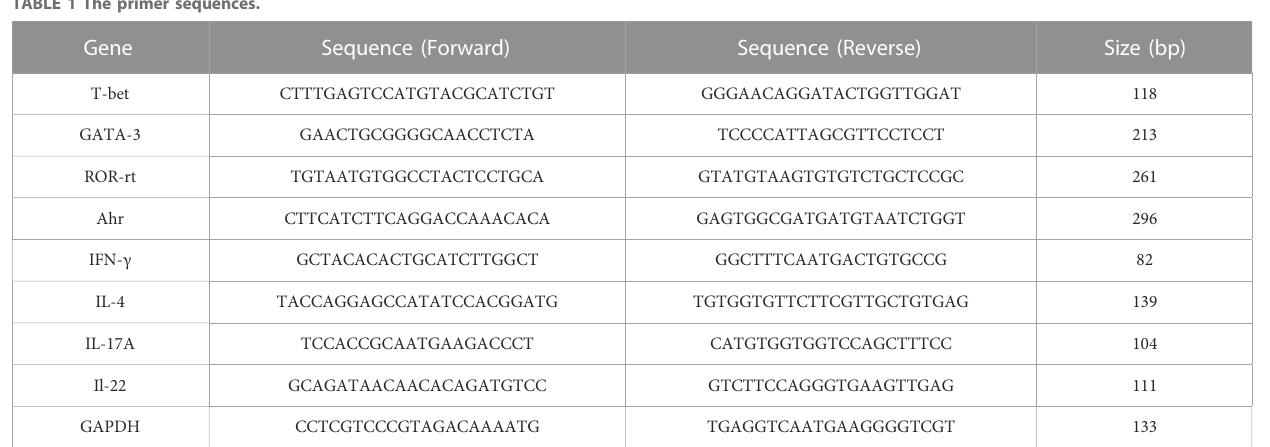
TABLE 1 The primer